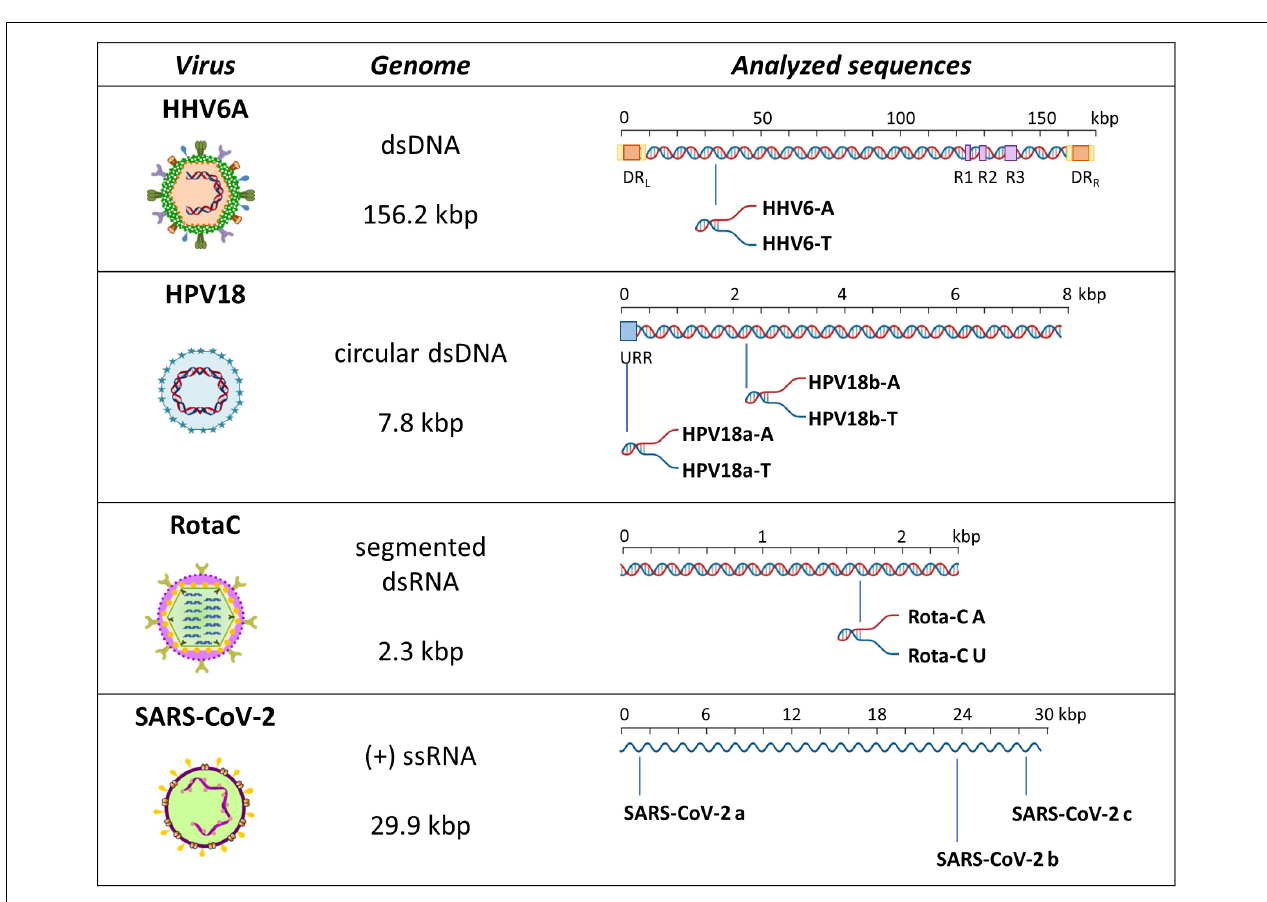
FIGURE 3 | Schematic representation of analyzed sequences. For each sequence, the relative virus, its genome features, and a schematic genome organization are reported. Adapted from Ruggiero and Richter (2018).